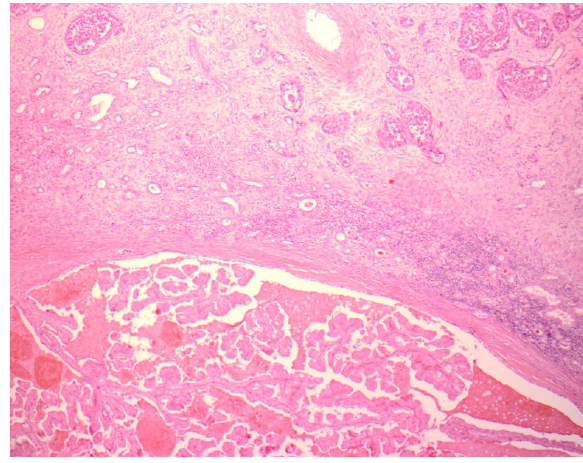
Figure 2 – HE staining showing the co-existence of CDC (top), with a nodule of oncocytoma (bottom).